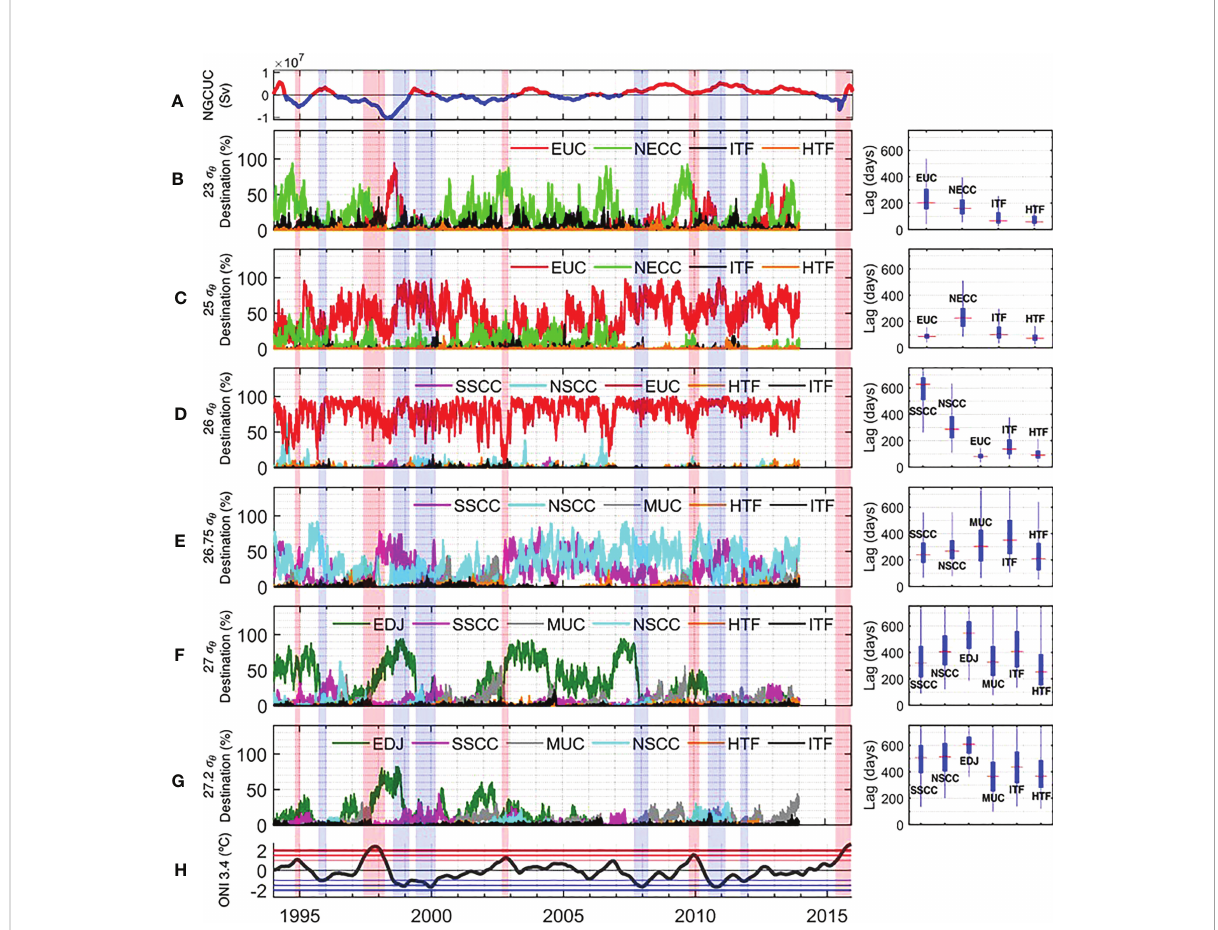
FIGURE 11 (A) The NGCUC transport ’ s anomaly (Sverdrup) from 1994 to 2015. Percentage of the tracers released from the NGCUC region that arrived at the prede fi ned sections of destination from 1994 to 2013 at the isopycnal layers of (B) 23, (C) 25, (D) 26, (E) 26.75, (F) 27, and (G) 27.2 s q . The right panels are box plot of the time lag (days), which is the travel time from the NGCUC region to arrive at the prede fi ned sections. (H) Ocean Niño Index 3.4 (°C) from 1994 to